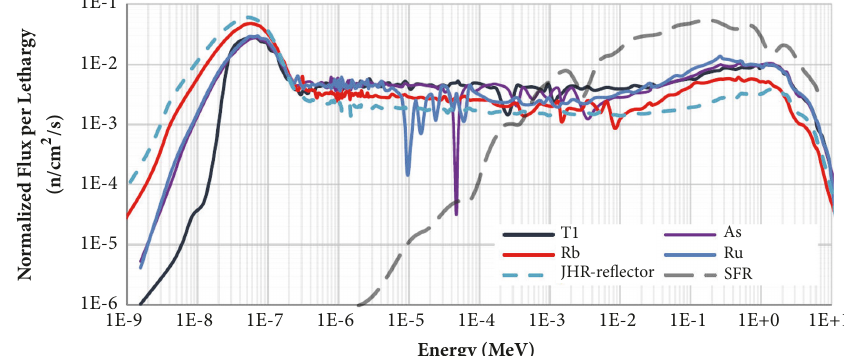
Figure 15: Effect of 3.4 cm Tl, As, Rb, and Ru neutron screens on the neutron spectrum. All screens provided sufficient neutron spectrum shifting and broadening but negligible thermal absorption capability.